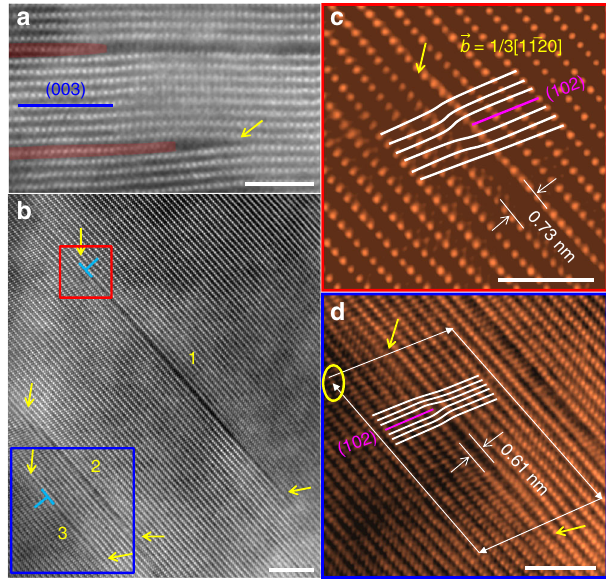
Fig. 2 Edge dislocations as nucleation sites of intragranular cracks in cycled LiNi 0.6 Mn 0.2 Co 0.2 O 2 . a Cracks connecting with edge dislocations with extra (003) planes. b Three intragranular cracks labeled as “ 1 ” , “ 2 ” and “ 3 ” . The yellow arrows indicate crack ends. c and d the enlarged region marked by the red and blue squares in ( b ). (102) extra planes are identi fi ed in “ 1 ” and “ 3 ” as highlighted in ( c ) and ( d ), respectively, verifying the edge dislocation in each crack. The scale bars are 3 nm in ( a ), ( c ) and ( d ); 5 nm in ( b